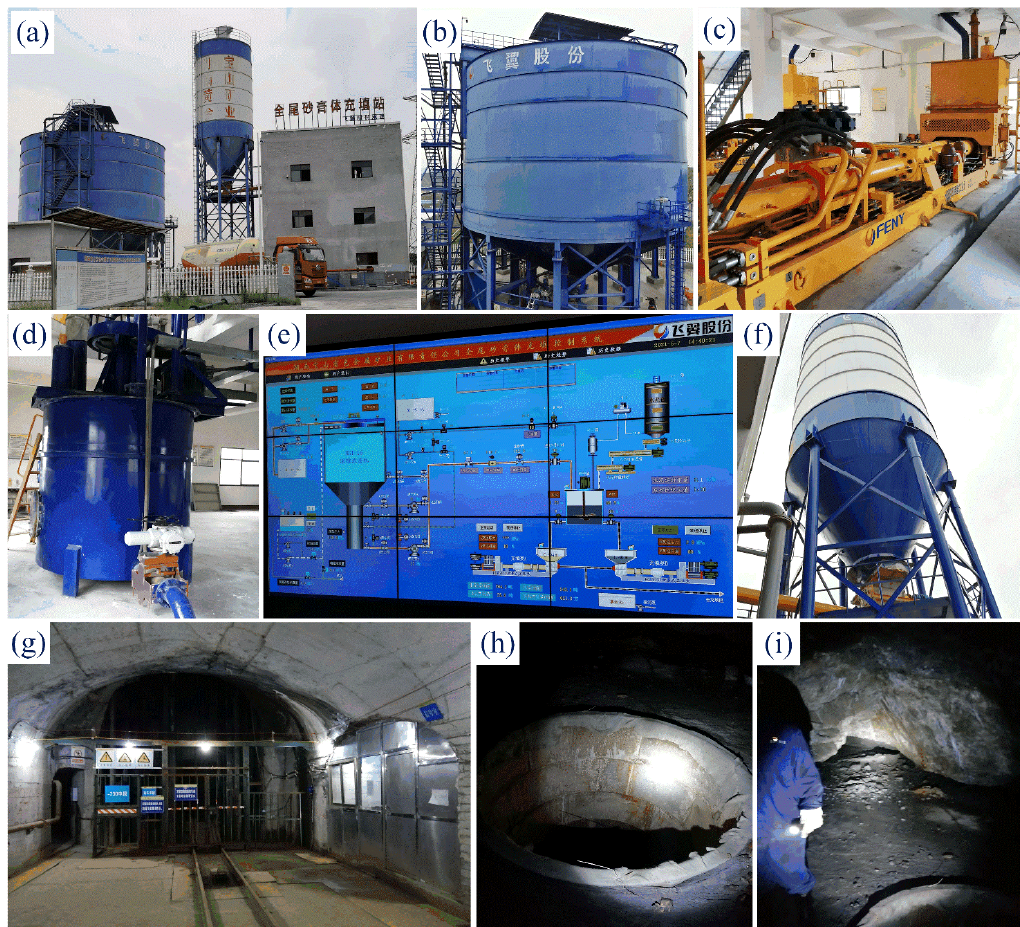
Figure 7. (Source: Hunan Baoshan Mining Co., LTD, Chenzhou, China) Configuration diagram of paste backfill system of Hunan Baoshan Mining Co., LTD: ( a ) panorama of backfill station; ( b ) deep cone thickener; ( c ) backfill industrial pump; ( d ) vertical stirring drum; ( e ) control systems; ( f ) cement silos; ( g ) man-material shaft; ( h ) stope chute; and ( i ) backfill body exposed in stope.